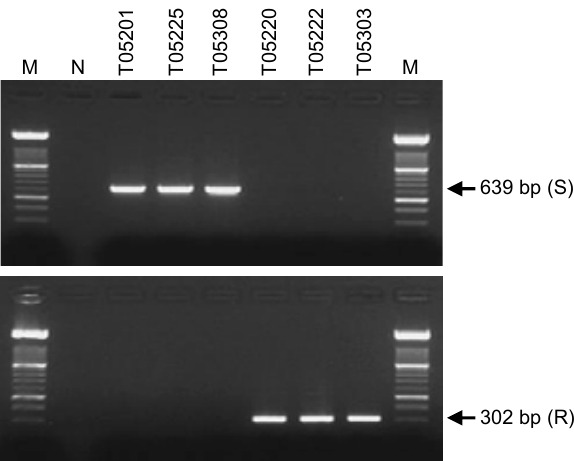
Figure 1. Mismatch amplification mutation assay on a part of the cytochrome b gene to determine the G143 or A143 al- lele in six Algerian isolates of Zymoseptoria tritici . Sensitive isolates carrying the G143 allele generated an amplicon of 639 bp. Resistant isolates carrying A143 allele generated an amplicon of 302 bp. Lane M, molecular size standard XIV (100-bp ladder). Lane N, negative PCR control containing no DNA template.